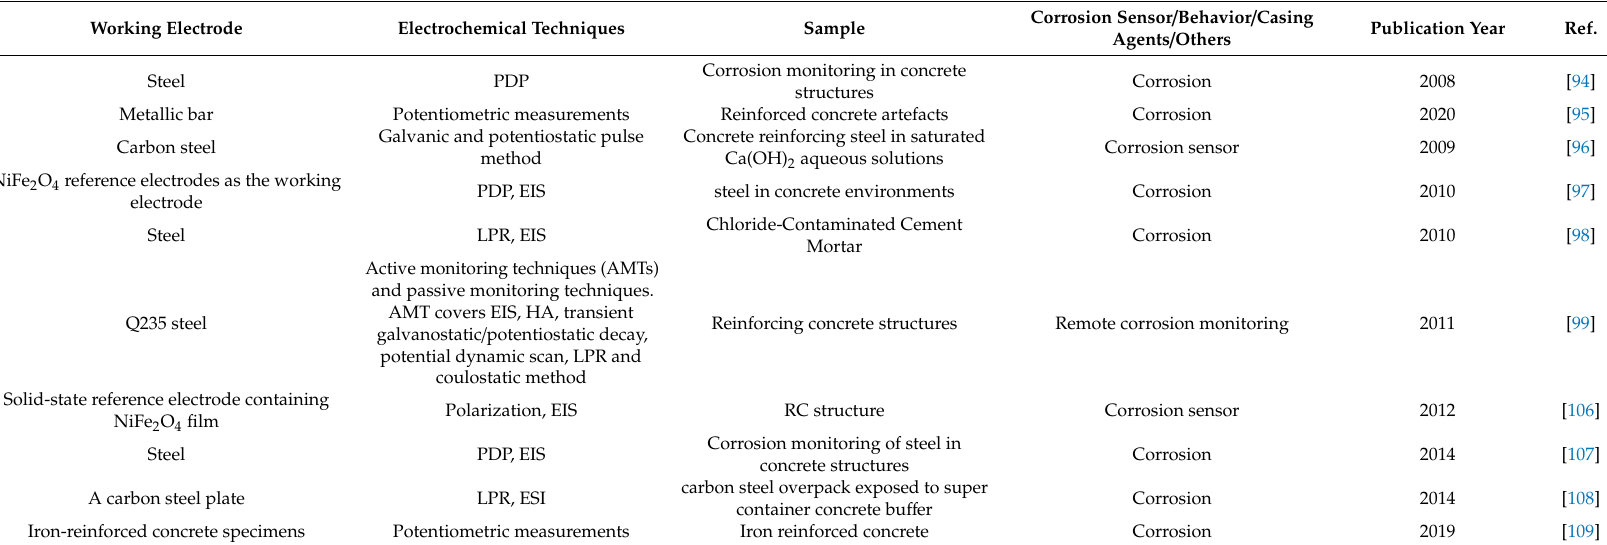
Table 6. Corrosion sensor for monitoring corrosion in